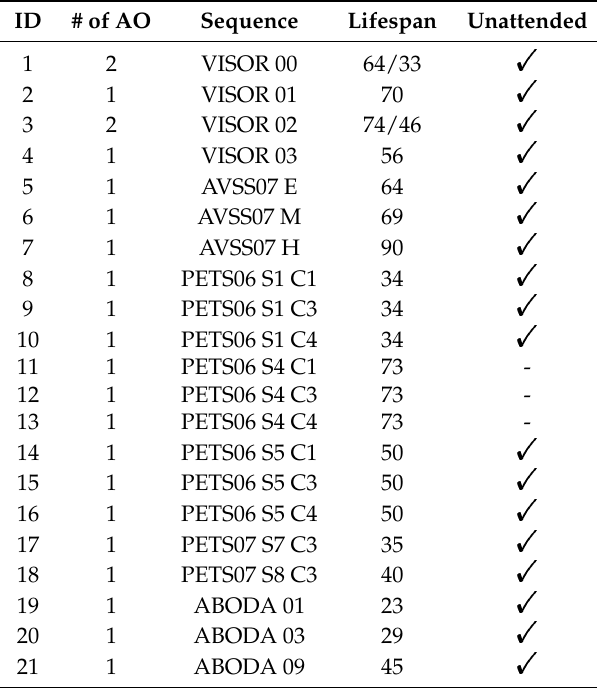
Table 5. Summary of annotated abandoned